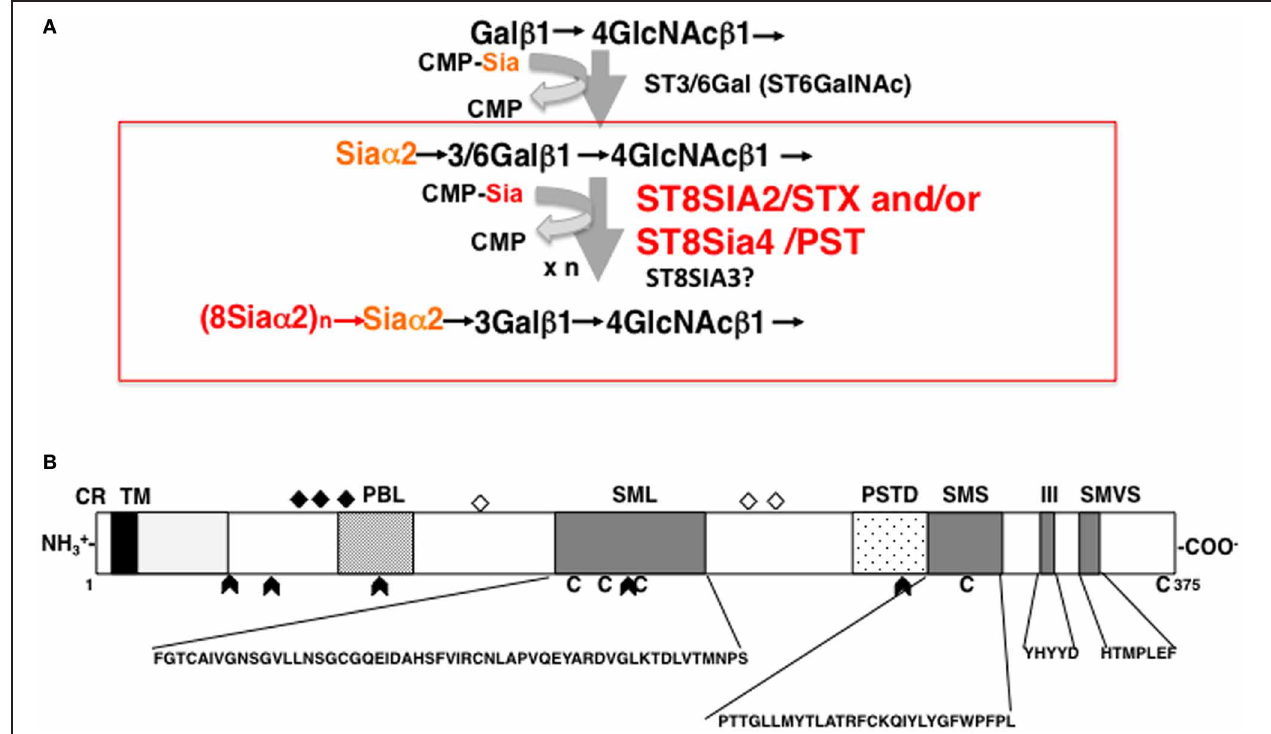
FIGURE 2 | Biosynthesis of polySia and schematic structure of ST8SIA2. (A) Mono and di/oligo/polysialylation pathway on the terminal Gal residue of N-glycan chains. Asialo-glycoprotein is mono-sialylated by the action of ST3/6GAL. ST8SIA2, ST8SIA4, and/or ST8SIA2/4 can synthesize polySia chains on the monosialyl residue, particularly on NCAM. (B) Schematic representation of the protein structure of ST8SIA2. ST8SIA2 consists of a short cytoplasmic region (CR) connected to a transmembrane (TM) region,